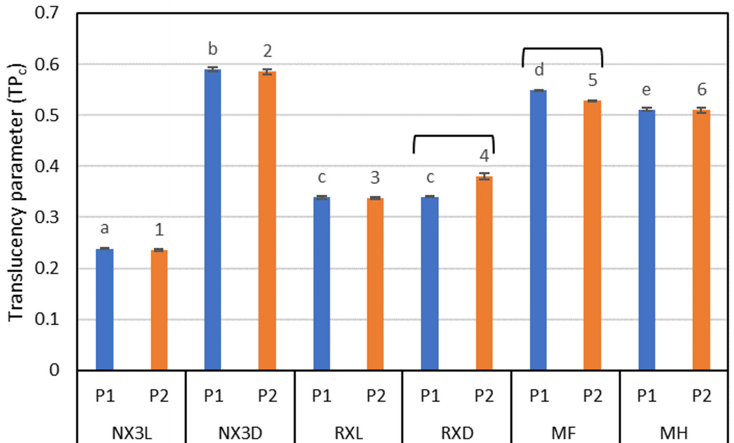
NX3L = NX3 light-cure, NX3D = NX3 dual-cure, RXL = RelyX Veneer, RXD = RelyX Ultimate, MF = Enamel Plus HRi Flow, MH = Enamel Plus HRi. Although RXD and MF reported different TP c values between protocols (both p = 0.00) (Figure 3), only ∆ TP c (P1/P2) of RXD exceeded the PTT (RXD = − 0.039 ± 0.006; MF = 0.020 ± 0.001).